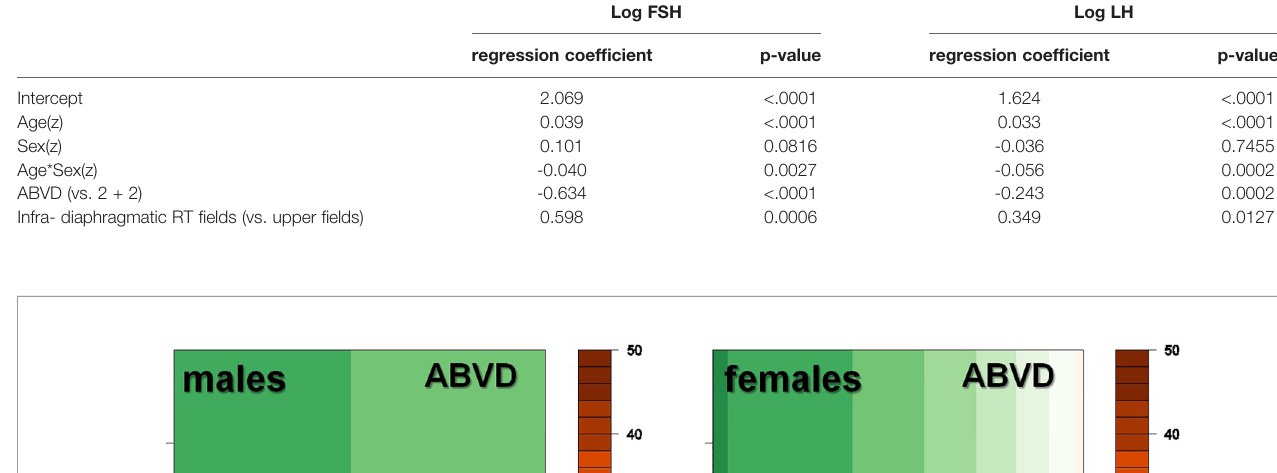
TABLE 3 | Multiple regression model of log. FSH and log. LH (weighted least squares, 258 females and 241 males, best linear unbiased estimators).